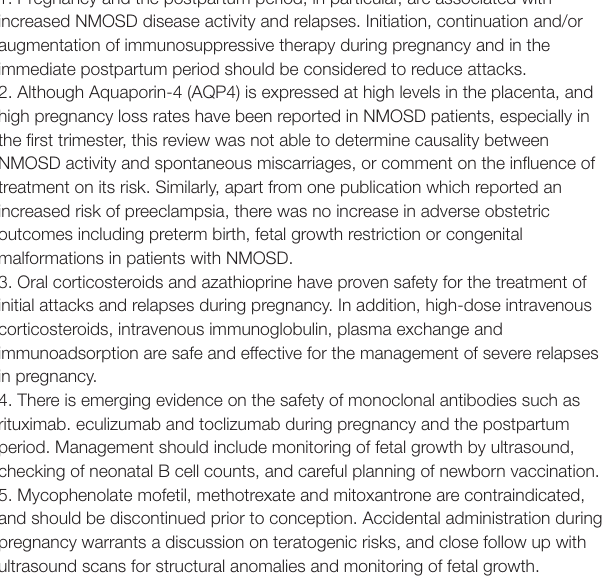
TABLE 3 | Key findings and recommendations for NMOSD and pregnancy (modified from Mao-Draayer et al.) (49). 1. Pregnancy and the postpartum period, in particular, are associated with increased NMOSD disease activity and relapses. Initiation, continuation and/or augmentation of immunosuppressive therapy during pregnancy and in the immediate postpartum period should be considered to reduce attacks. 2. Although Aquaporin-4 (AQP4) is expressed at high levels in the placenta, and high pregnancy loss rates have been reported in NMOSD patients, especially in the first trimester, this review was not able to determine causality between NMOSD activity and spontaneous miscarriages, or comment on the influence of treatment on its risk. Similarly, apart from one publication which reported an increased risk of preeclampsia, there was no increase in adverse obstetric outcomes including preterm birth, fetal growth restriction or congenital malformations in patients with